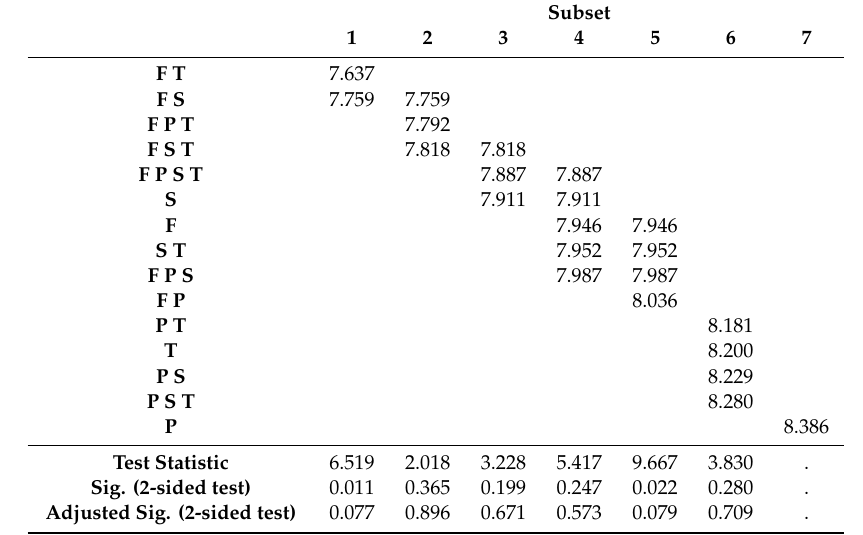
Table 6. Homogeneous subsets based on Freidman ranking and asymptotic significances